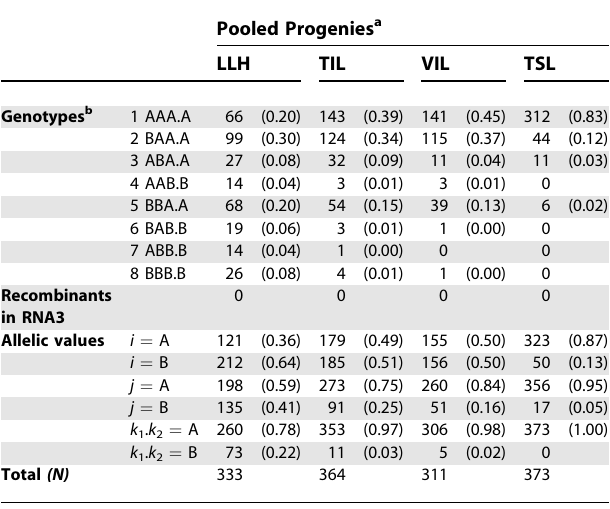
a Data are number of descendents and frequencies referred to the total of the progeny (between